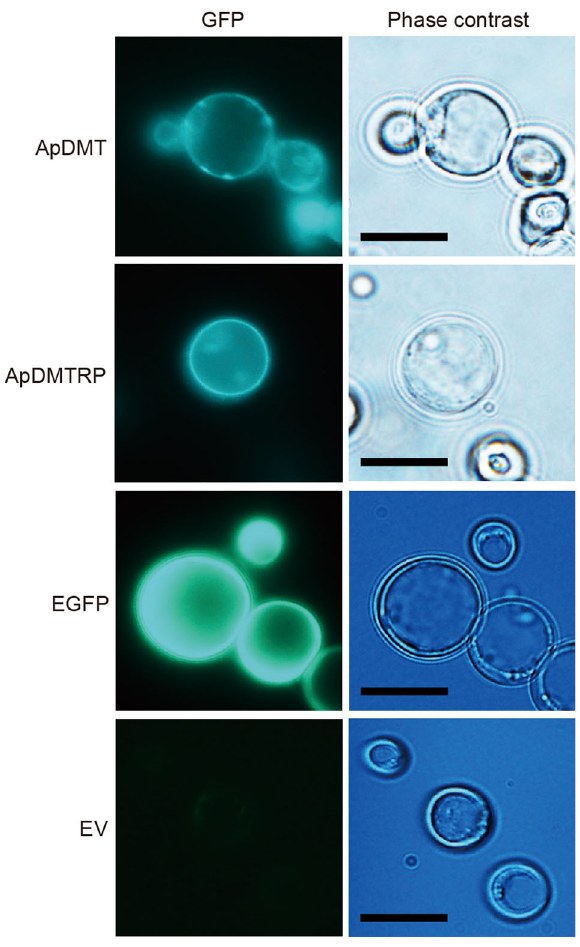
Fig. 5 Subcellular localization of the crown-of-thorns star fi sh (COTS), Acanthaster planci , divalent metal transporter (ApDMT) and DMT- related proteins (ApDMTRP) fused with EGFP expressed in yeasts. Yeasts (DY1457) were transformed with ApDMT and ApDMTRP genes fused to the EGFP gene and observed with fl uorescent and phase contrast microscopy. Yeasts expressing EGFP alone (EGFP) and those transformed with an empty vector (EV) are shown for comparison. The scale bar is 10 μ